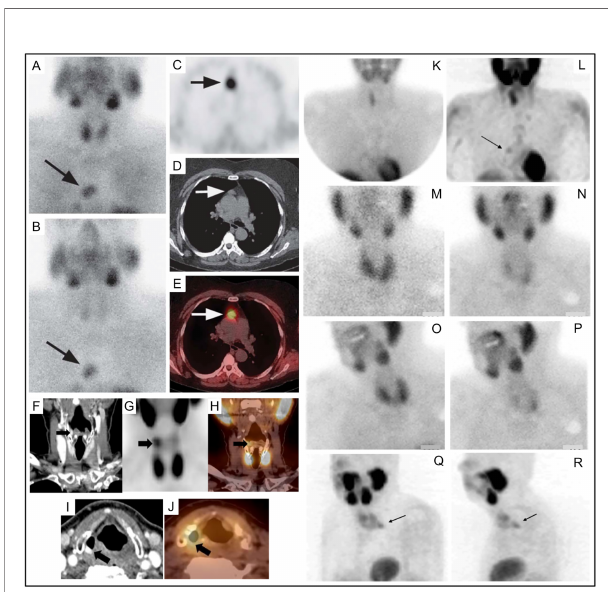
FIGURE 6 | Parathyroid planar imaging should include the mediastinum, where a large percentage of ectopic PA occur. Planar scintigraphy of an ectopic PA (A) 20min and (B) delayed 2h. 99m Tc-sestamibi SPECT/CT imaging can aid in anatomical localization and is particularly helpful for ectopic PA. 99m Tc-sestamibi SPECT/CT of mediastinal PA on axial SPECT [ (C) -black arrow], axial CT [ (D) -white arrow], and axial fused SPECT/CT [ (E) -white arrow]. 99m Tc-sestamibi SPECT/CT of an ectopic PA in a particularly rare position near the right piriform sinus on coronal CECT [ (F) -black arrow], coronal SPECT [ (G) -black arrow], coronal fused SPECT/CT [ (H) -black arrow], axial CECT [ (I) -black arrow], axial fused SPECT/CT [ (J) -black arrow]. SPECT imaging can also be helpful when planar imaging is negative (K, M, N) as in (L) showing mediastinal PA (arrow) adjacent to the cardiac border. Another PA behind the left lobe of the thyroid was not identi fi ed on planar anterior early 99mTc-sestamibi (M) , delayed 99mTc-sestamibi (N) , or on planar oblique images (O, P) , but was identi fi ed on SPECT [ (Q, R) , arrows]. Reproduced with permission from: (A – E) Wong KK, Fig LM, Gross MD, Dwamena BA. Parathyroid adenoma localization with 99mTc-sestamibi SPECT/CT: a meta-analysis. Nucl Med Commun. 2015 Apr;36(4):363-75. doi: 10.1097/MNM.0000000000000262. PMID: 25642803. (F – J) Hsieh MP, Nemer JS, Beylergil V, Yeh R. Ectopic Parathyroid Adenoma of the Piriform Sinus on Parathyroid 4D-CT and 99mTc-MIBI SPECT/CT. Clin Nucl Med. 2020 Aug;45(8):e358-e359. doi: 10.1097/RLU.0000000000003163. PMID: 32558723